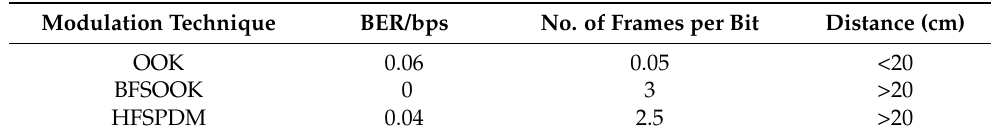
Figure 19. Accuracy Comparison of OOK, BFSOOK and HFSPDM. Table 3. HFSPDM vs. OOK vs.